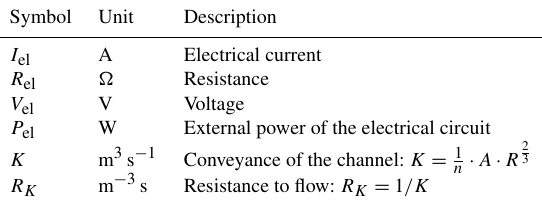
Table C2. Additional